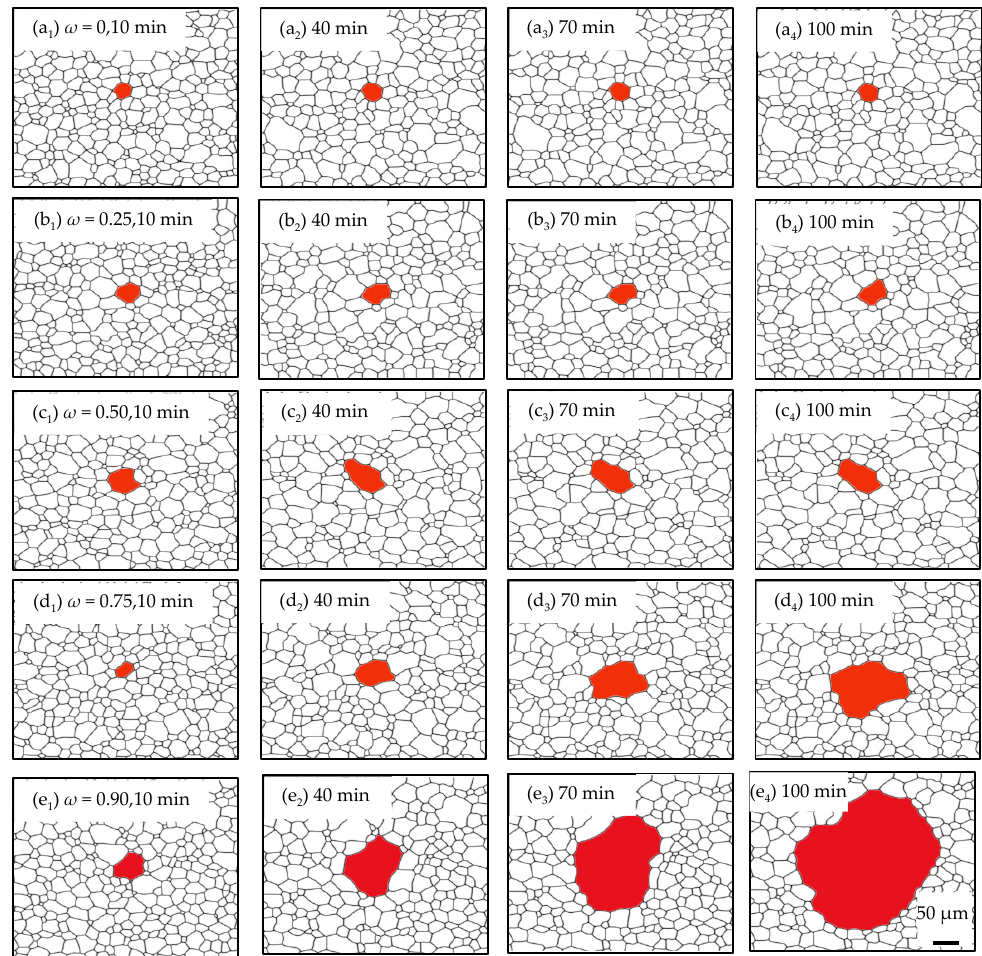
Figure 9. Microstructure evolution under various ω s (0–0.90) where T = 1273 K and c = 0.10%. ( a 1 – a 4 ) ω =0, 10-100 min;( b 1 – b 4 ) ω = 0.25, 10-100 min;( c 1 – c 4 ) ω = 0.50, 10-100 min;( d 1 – d 4 ) ω = 0.75, 10-100 min;( e 1 – e 4 ) ω = 0.90, 10-100 min.